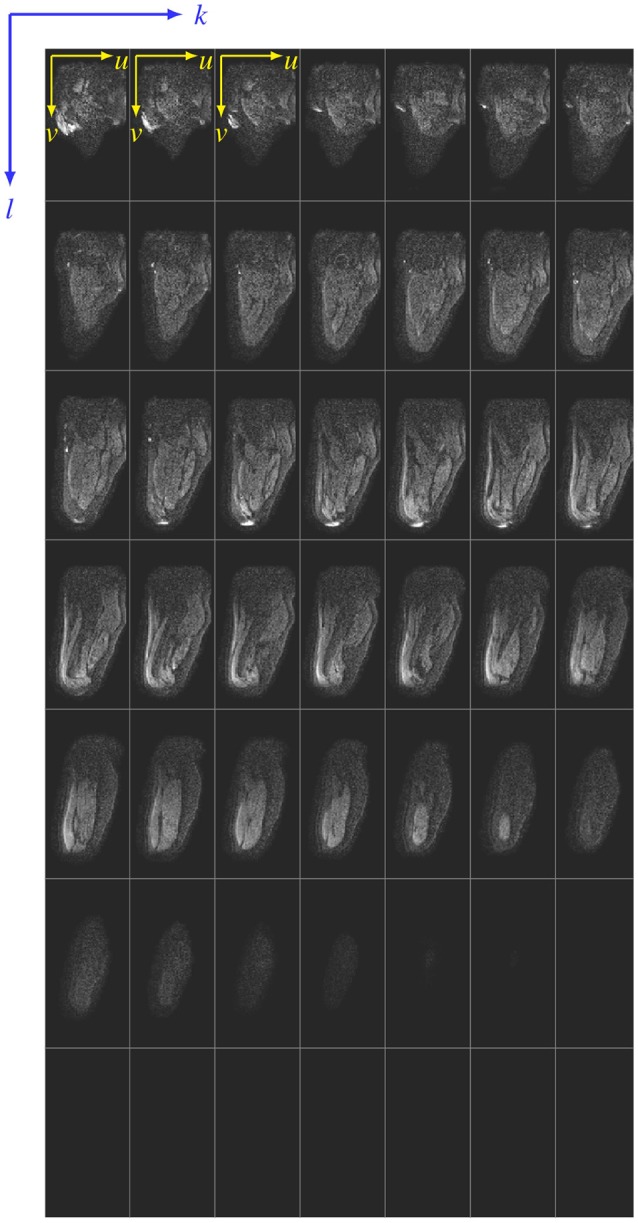
Siemens mosaic file. A sample mosaic image is shown here. For the sake of illustration, the 2D slices that make up the mosaic are separated by thin lines. Any pixel in the mosaic can be accessed using two coordinate systems–the [k, l] coordinate that references a 2D slice in the mosaic, and the [u, v] coordinate that references a pixel in the 2D slice referenced by [k, l].